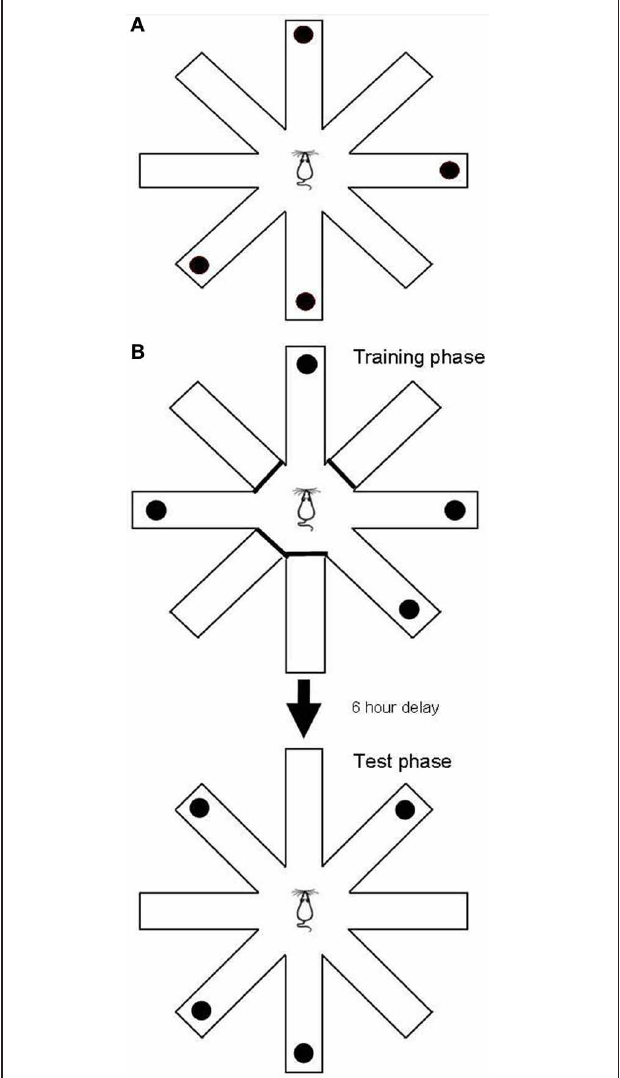
FIGURE 1 | (A) The RFNDT required the rat to locate four pellets located in randomly chosen arms with all eight arms open. (B) The DSWT task had two phases: the training phase in which four randomly selected arms were open and baited, and the test phase, in which all arms were open and the four previously closed arms were